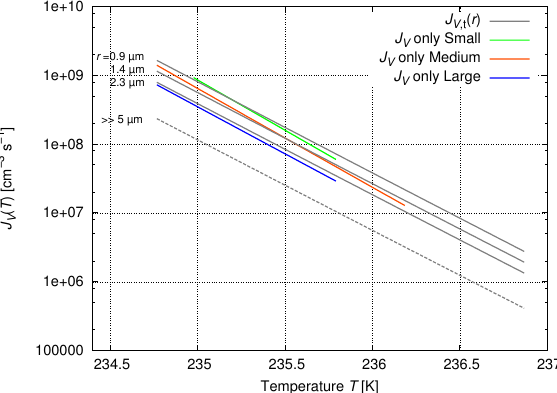
Fig. 4. Results for J V (assuming volume only freezing, cfr. Fig. 1) compared with volume-specific total nucleation rate coefficients J V , t determined from fits assuming both volume and surface nu- cleation. The surface contribution is incorporated into the volume- specific rate coefficient J V , t , which therefore becomes size depen- dent. The J V , t curves corresponding to the three aerosol sizes agree well with the J V curves, as expected. Note that instead of the mean radii (1.0, 1.7 and 2.9µm), the radii of spheres with average volume have been used for this comparison. These radii are 0.9, 1.4, and 2.3µm for the small, medium and large aerosols. The limiting case of large droplets is also shown (labeled as “ r (cid:29)